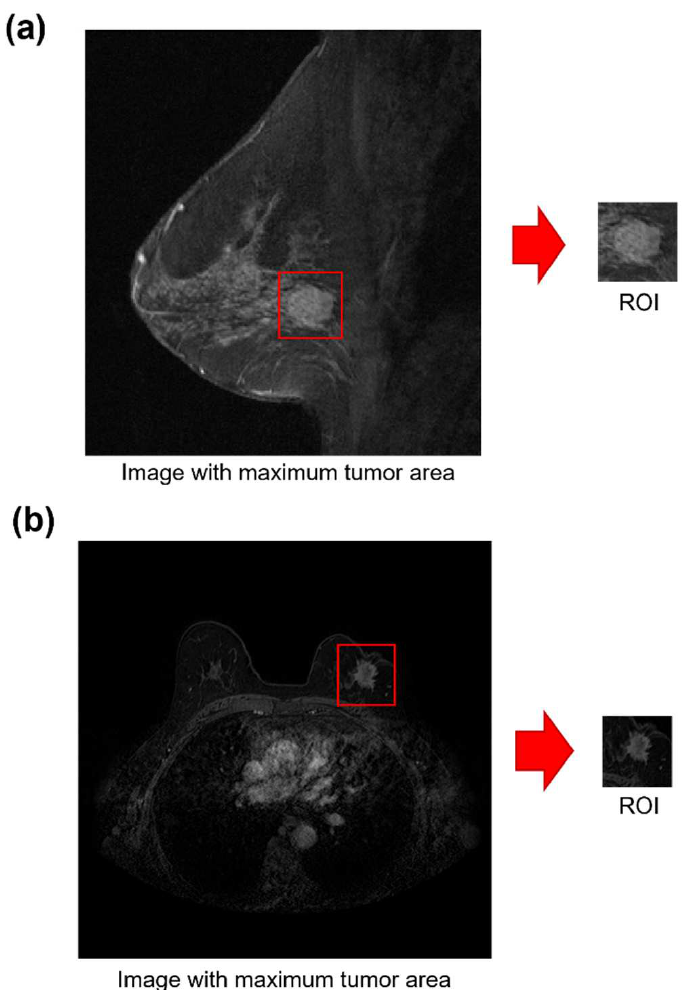
Figure 1. Examples of baseline MR image acquired according to ( a ) a sagittal view of a public DB patient and ( b ) an axial view of a private DB patient.